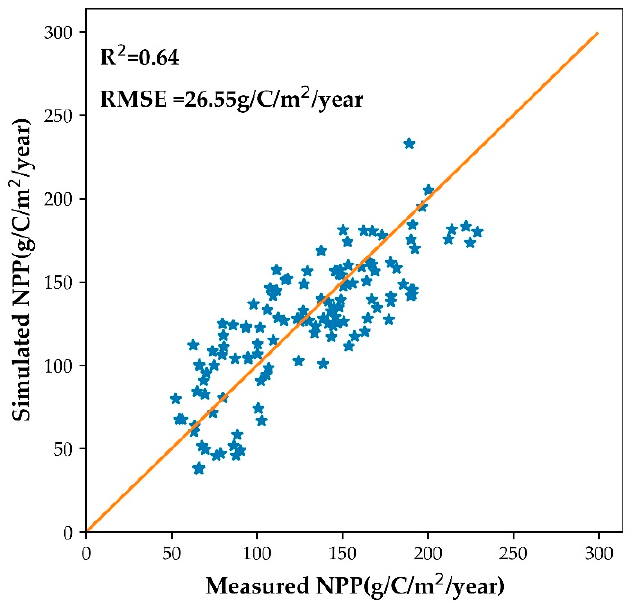
Figure 6. Validation of interannual NPP of the calibrated Biome-BGCMuSo model with NPP from dendrochronological data time series.